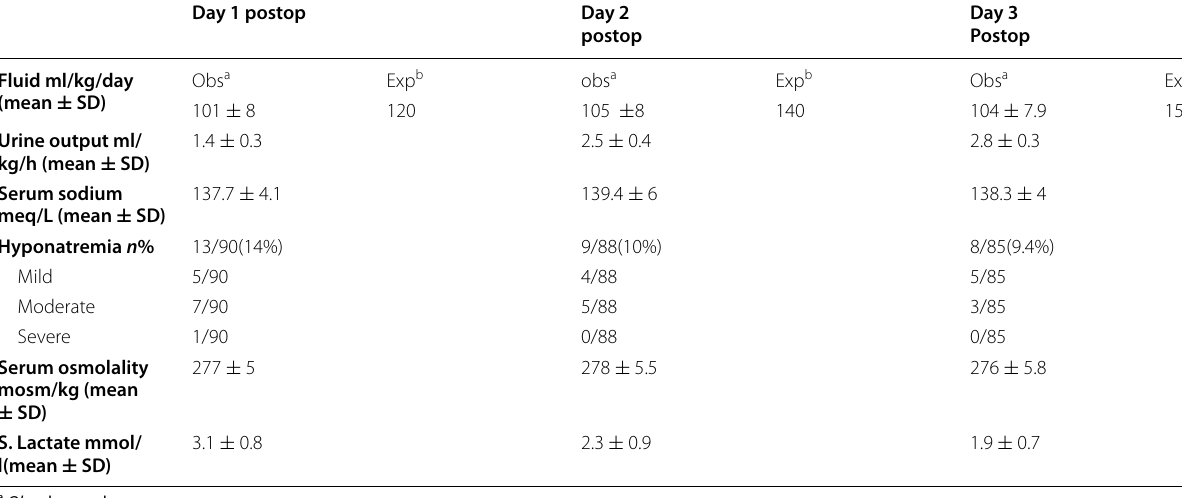
Table 3 Postoperative fluid and electrolyte data of the neonates